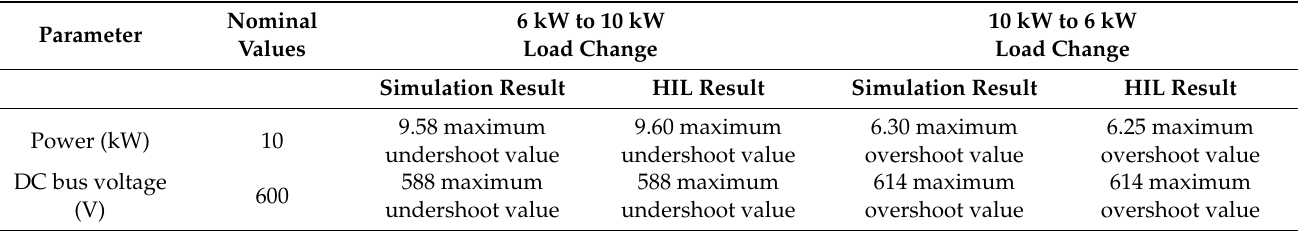
Table 4. Comparison of offline simulation and hardware-in-the-loop